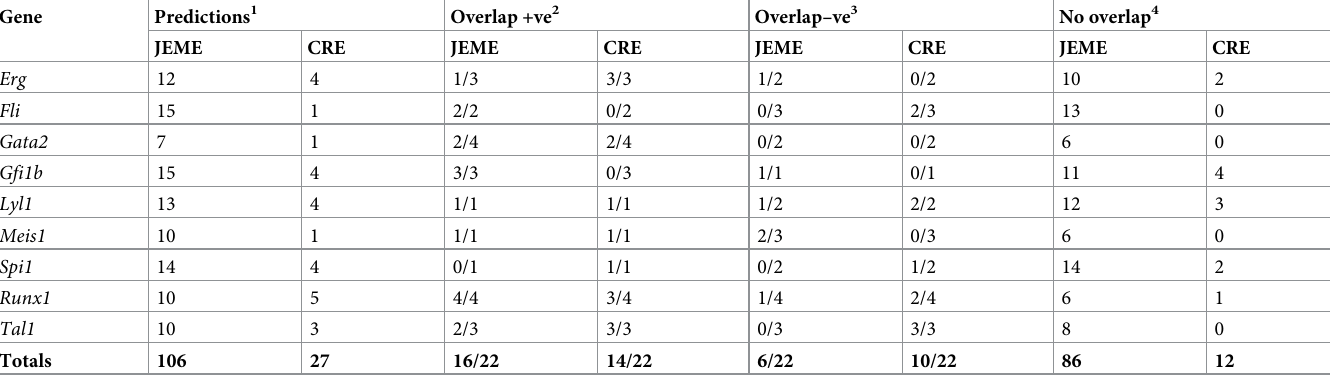
Table 3. Overlaps of predicted regulatory elements with experimentally tested